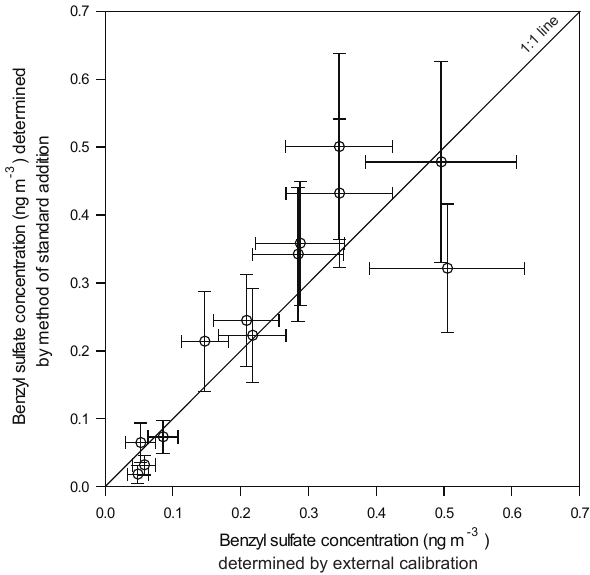
Fig. 4. Comparison of concentrations of benzyl sulfate in PM 2 . 5 determined by UPLC TQ MS by the methods of external calibra- tion and standard addition. Error bars represent the analytical un-